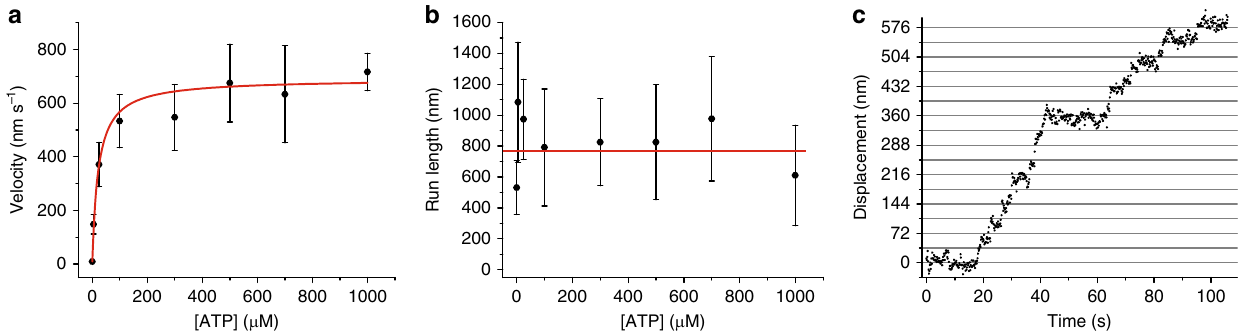
Fig. 2 Signatures of single myosin-5B molecule motility under unloaded condition. a The velocity of myosin-5B movement ( n = 127) on F-actin increases with increasing ATP following Michaelis – Menten kinetics (red curve), with v max = 691 ± 25 nm s − 1 and K app = 22 ± 2 µ M. Error bars, s.d. b The run length ( n = 127) is ATP-independent within error bars. Average run length is 780 ± 2 nm (red line). Error bars, s.d. c Representative time trace of